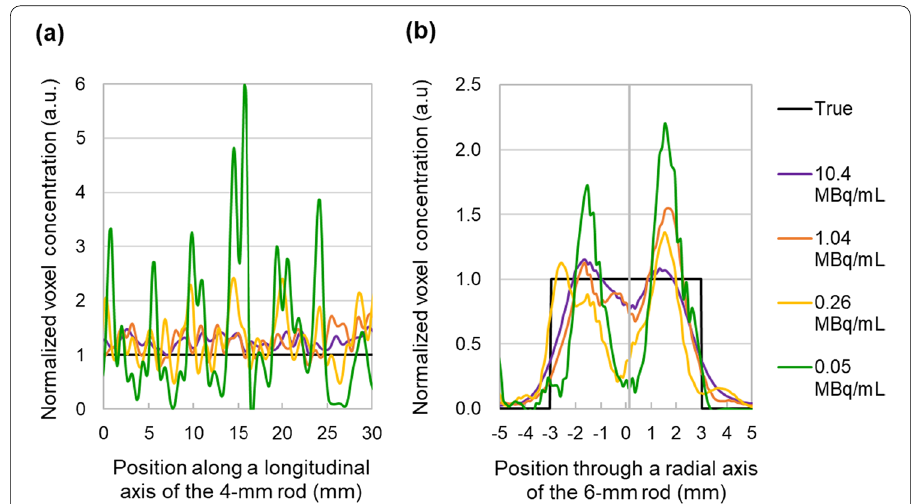
(emulated) 131 I activity concentrations (same series legend for the two sub-figures) of the phantom scan